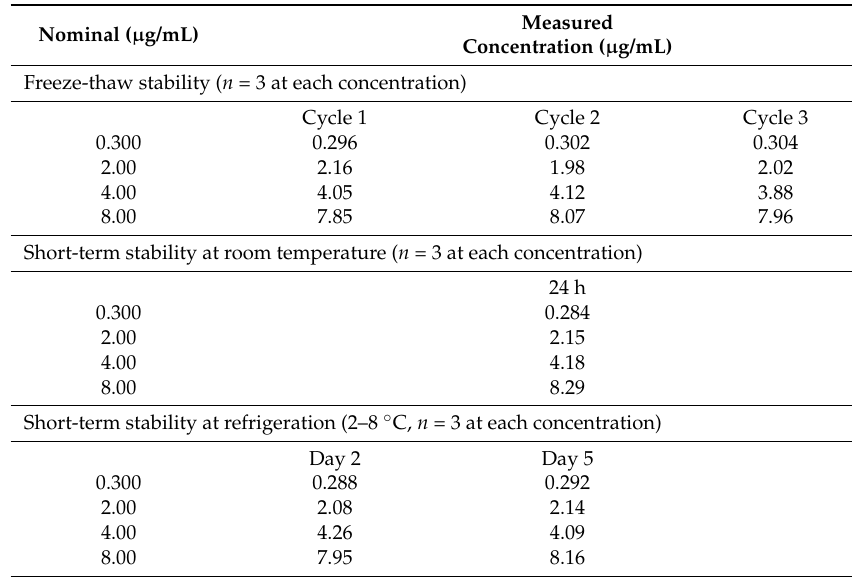
Table 4. Stability data for posaconazole in QC